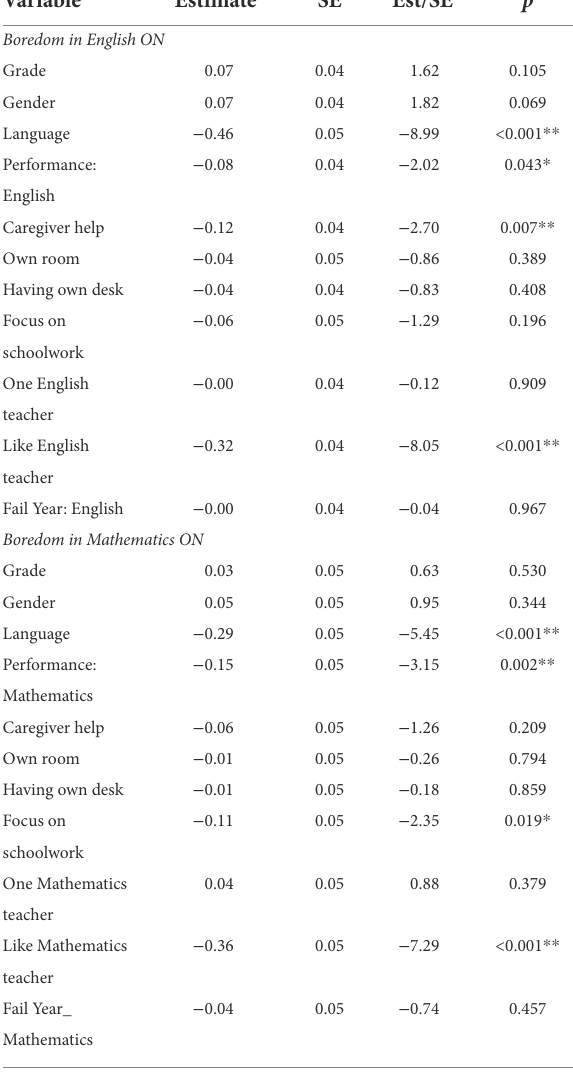
TABLE 4 Standardized regression coefficients with Boredom in English and Mathematics as dependent variables.